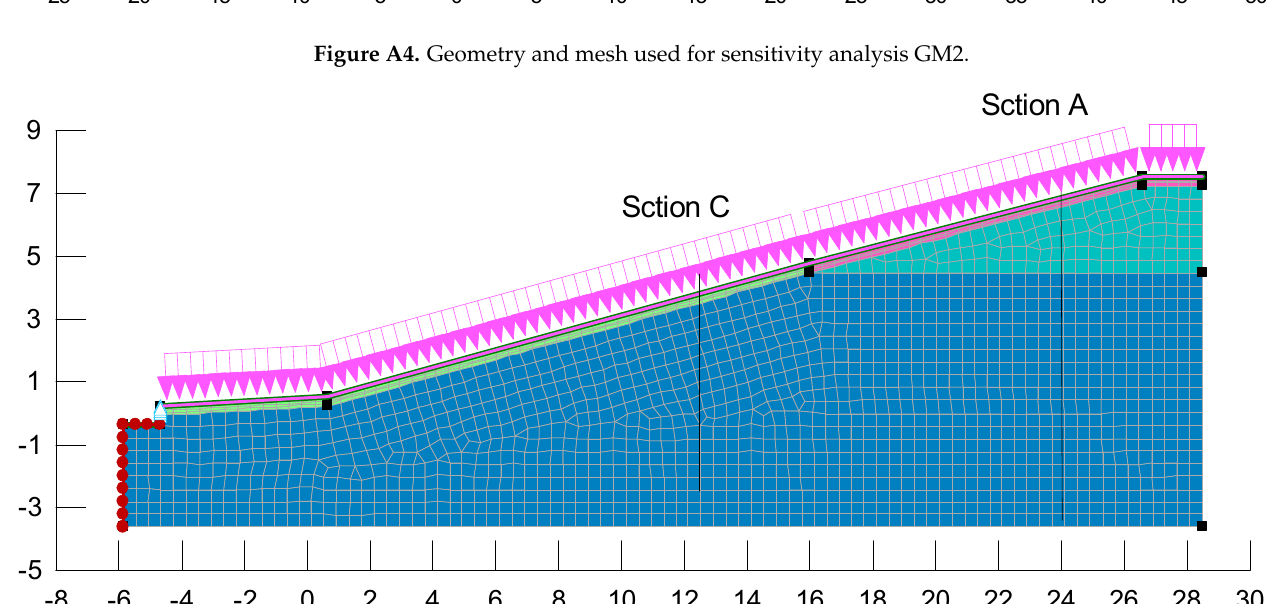
Figure A5. Geometry and mesh used for sensitivity analysis GM3.